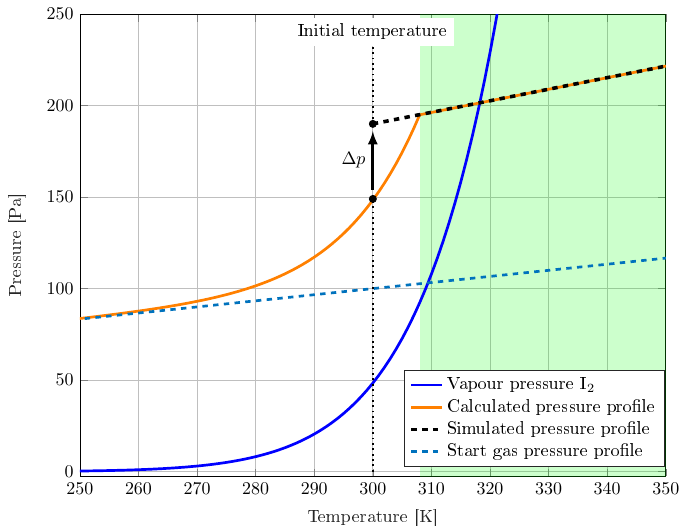
Figure 1. Pressure curve over the temperature of a discharge with 100Pa of Xe as well as 1mg of I 2 . The green marked area corresponds to the area of an unsaturated discharge.